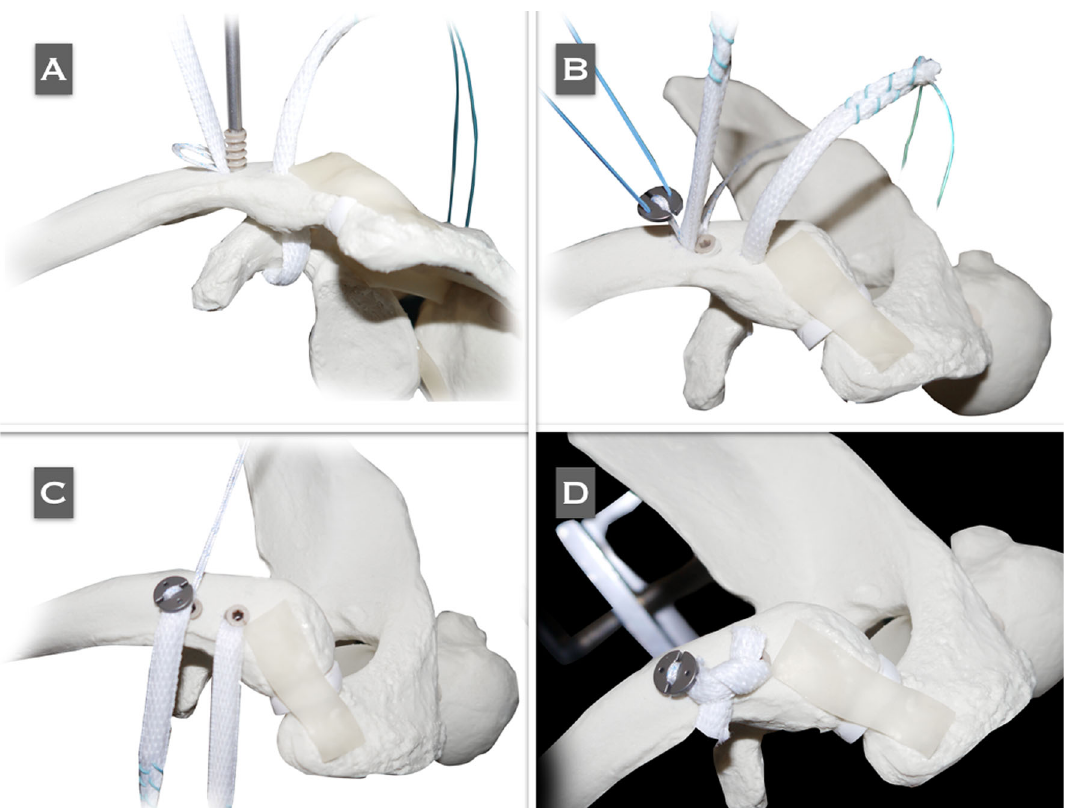
Fig. 5 a Before the ZipTight is tensioned, the graft should be fixed in the clavicular portion of the conoid tunnel with a 4.5- to 5.5-mm (same diameter of the tunnel) bio-tenodesis interference screw. Reproduced with permission and copyright (cid:2) of Arthroscopy Tech- niques, Elsevier. b Both limbs of the graft coming out of the clavicle when fixed in both tunnels with bio-tenodesis interference screws. The ZipTight is tied by threading the sliding suture in the washer. To avoid any harm to the sutures of the ZipTight with the screw, the graft